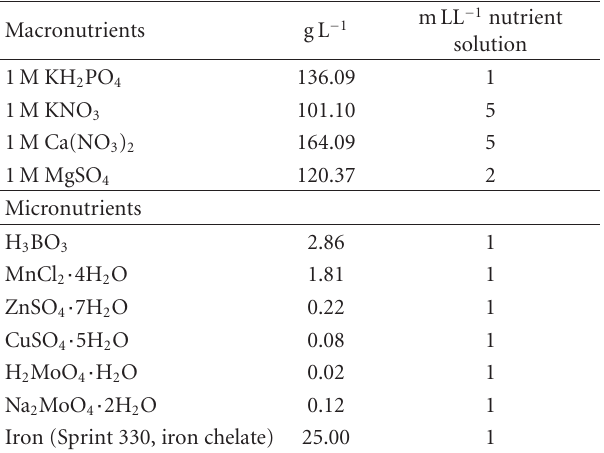
Table 2: Nutrient elements content of Hoagland